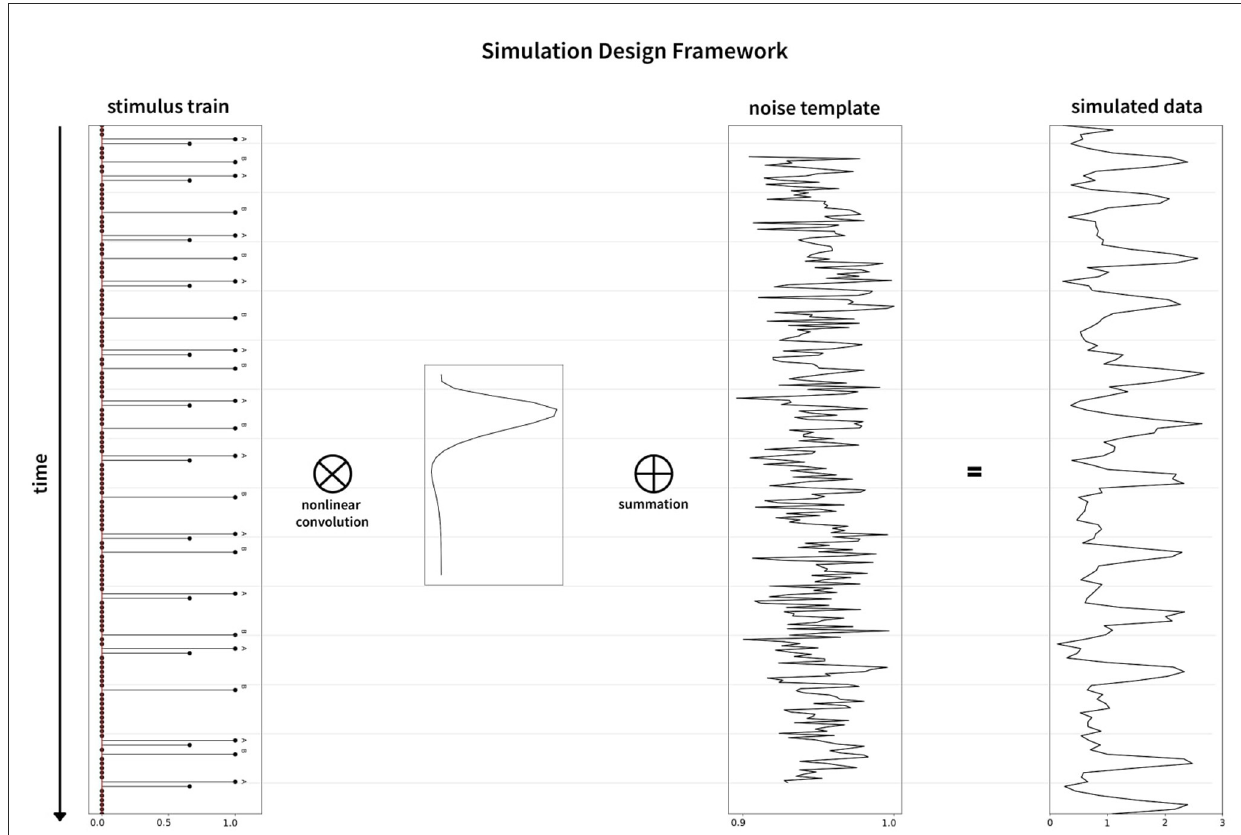
FIGURE6 Graphical representation of the simulation framework. The stimulus train (left) is convolved nonlinearly with the hemodynamic response function (inset between stimulus train and noise template), followed by addition of the noise template (middle) to generate the simulated data (right)